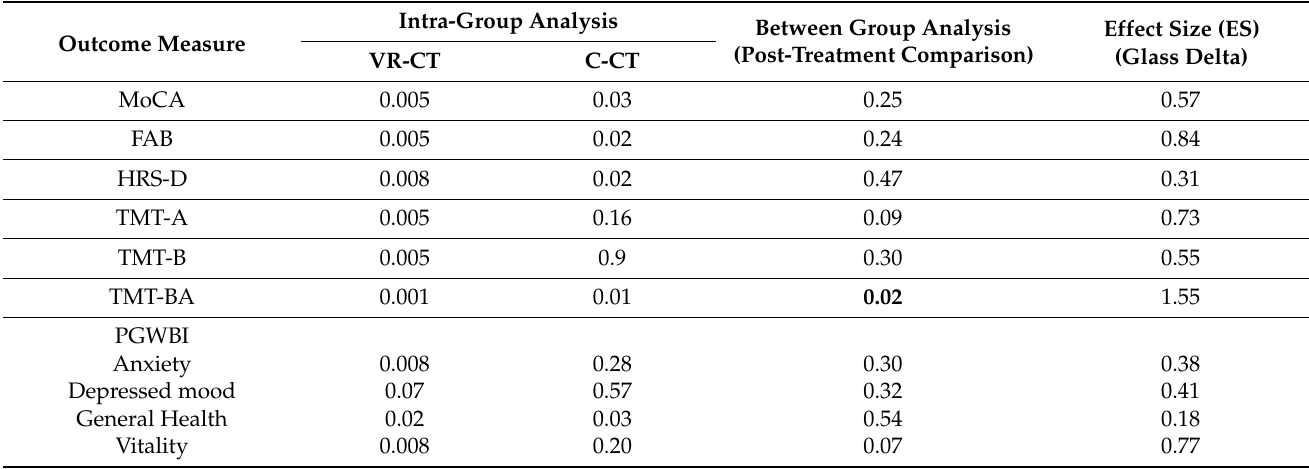
Table 4. Statistical comparison of clinical score variations from baseline to follow-up